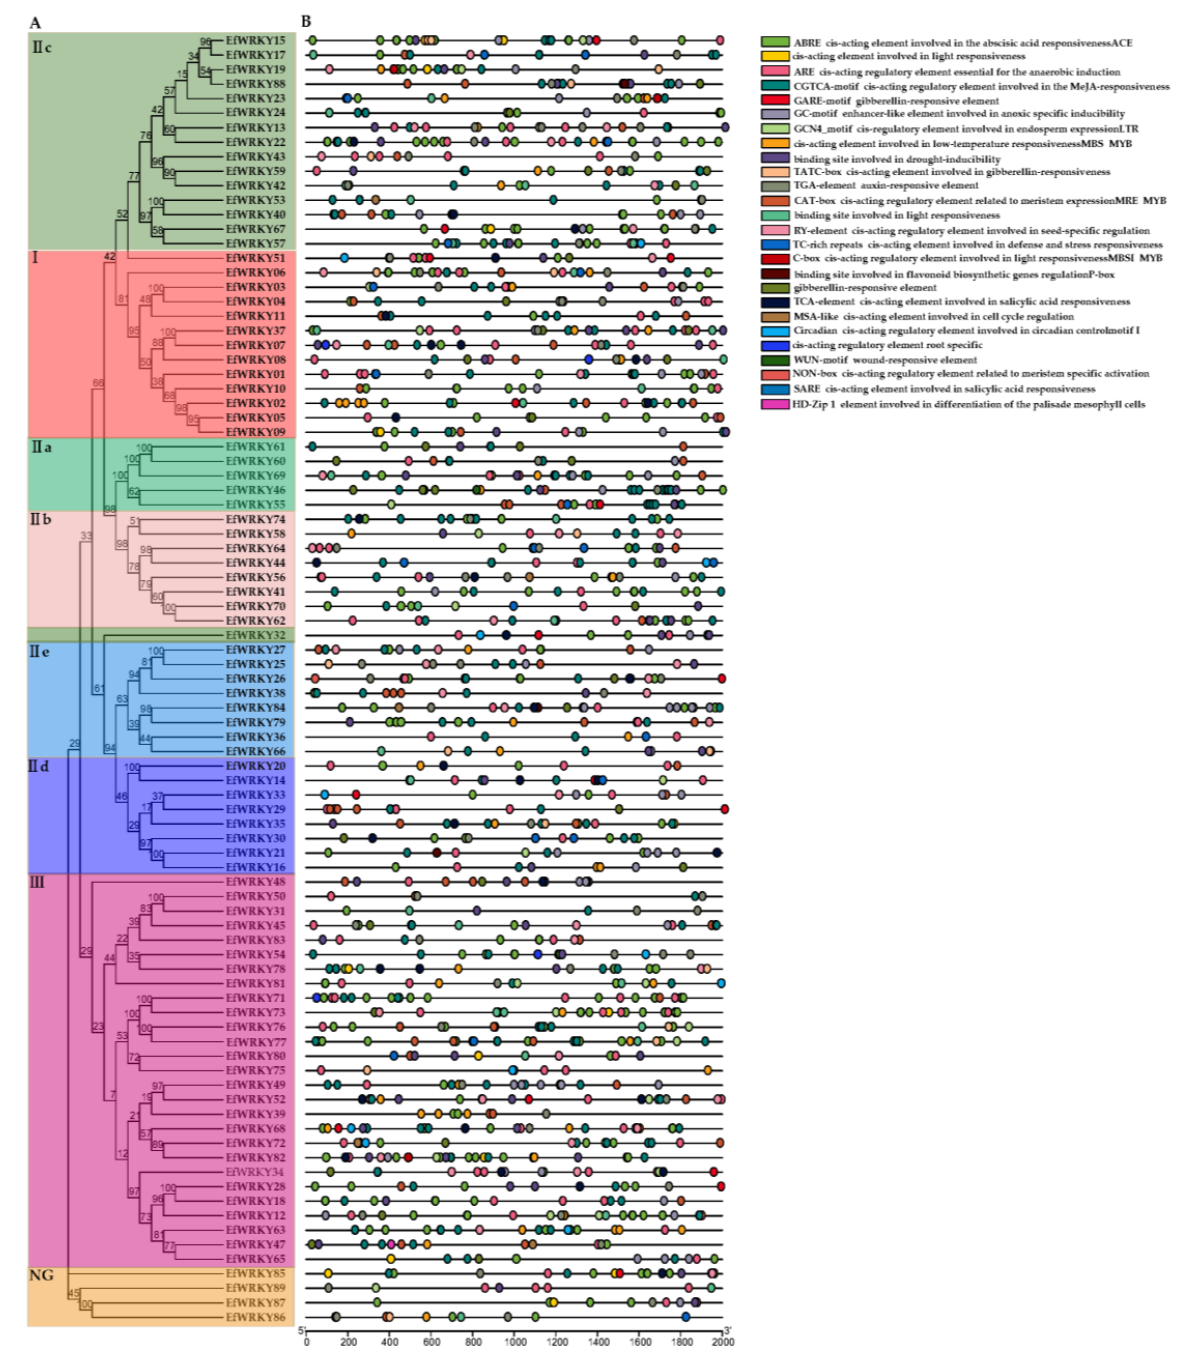
Figure 4. Cis-element analysis of the EfWRKY gene family. Different colors represent a total of 26 types of functional modules. ( A ) Phylogenetic tree of 89 EfWRKY genes. Numbers on branches represent bootstrap estimates for 1000 replicate analysis or clade credibility values. ( B ) Cis-acting ele- ments.